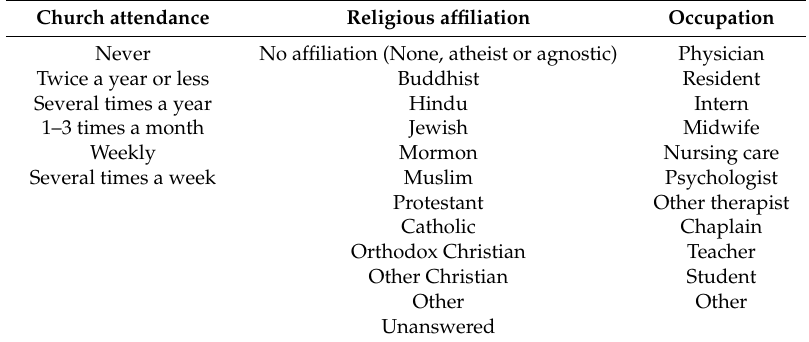
Table 1. Included options for ’Church attendance’, ‘Religious affiliation’, and ‘Occupation’ items.